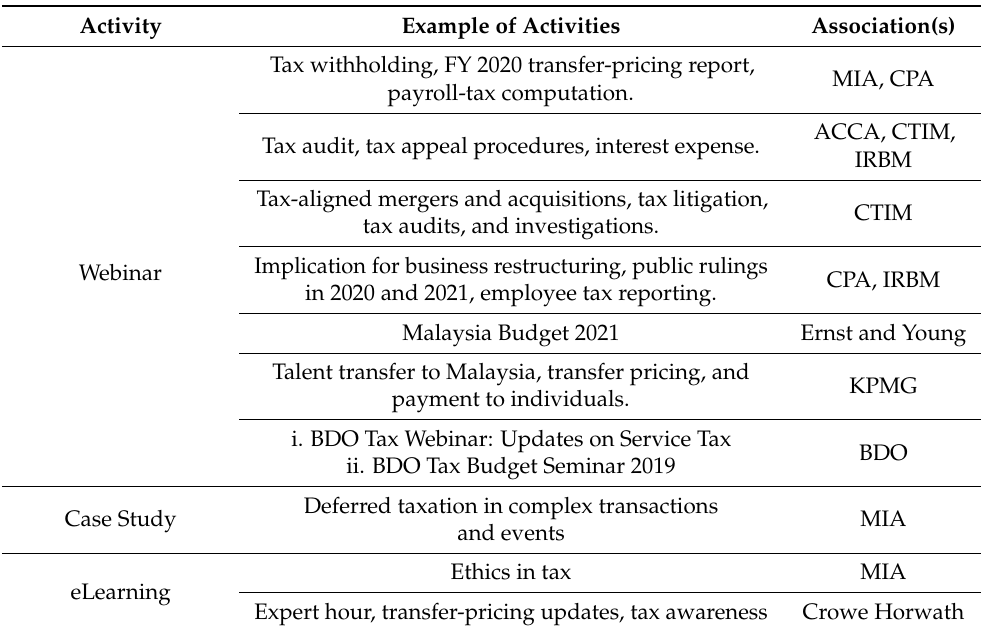
Figure 3. Tax-knowledge flows among entities. Table 2. List of knowledge sources and